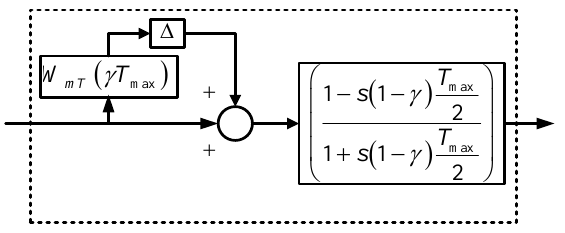
Figure 3. Configuration of time delay uncertainty